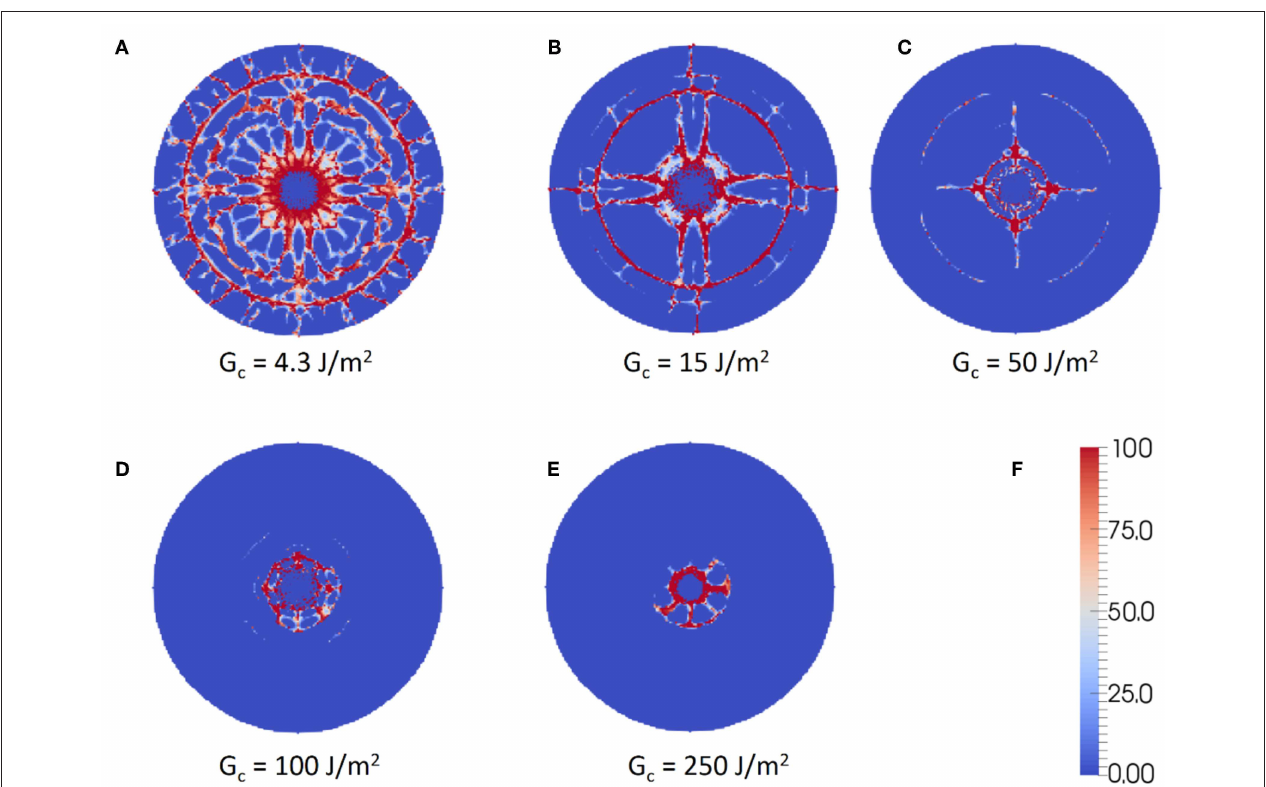
FIGURE 10 | Damage map in the glass plates with different fracture energies, namely, (A) 4.3 J/m 2 , (B) 15 J/m 2 , (C) 50 J/m 2 , (D) 100 J/m 2 , and (E) 250 J/m 2 , subjected to impact. (F) The coloring scheme used to denote the local damage in percent. Note that 100 corresponds to a particle with all the bonds broken, and 0 to a particle with all the bonds